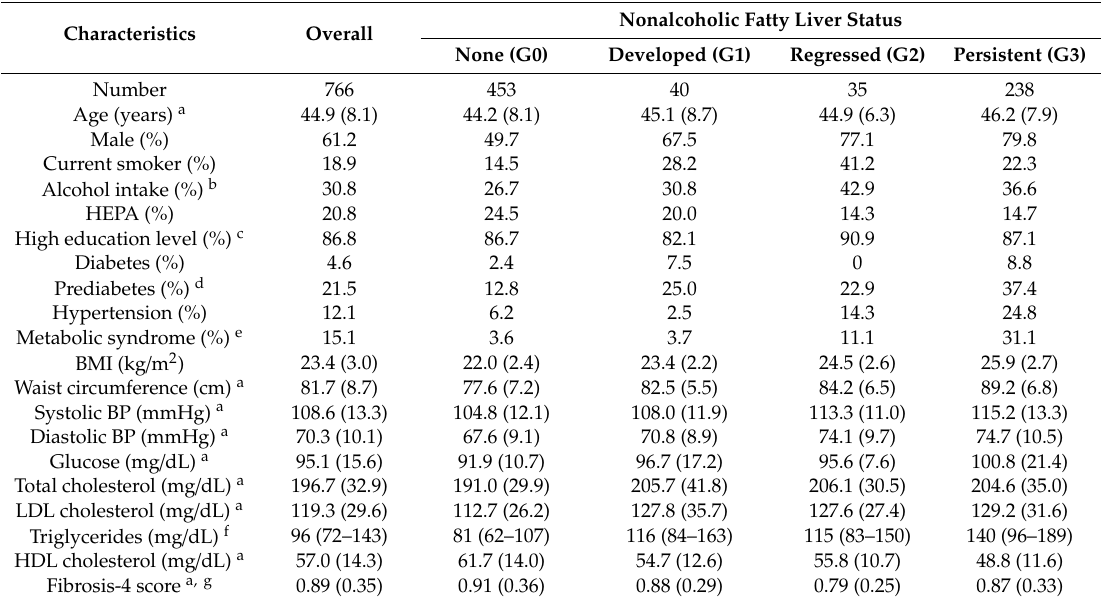
Table 1. Baseline characteristics of study participants by nonalcoholic fatty liver